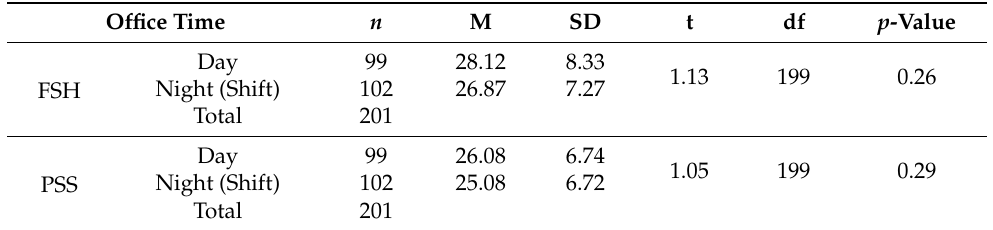
Table 8. Independent sample t -test of fear of sexual crime and personal safety as per shift work. Office